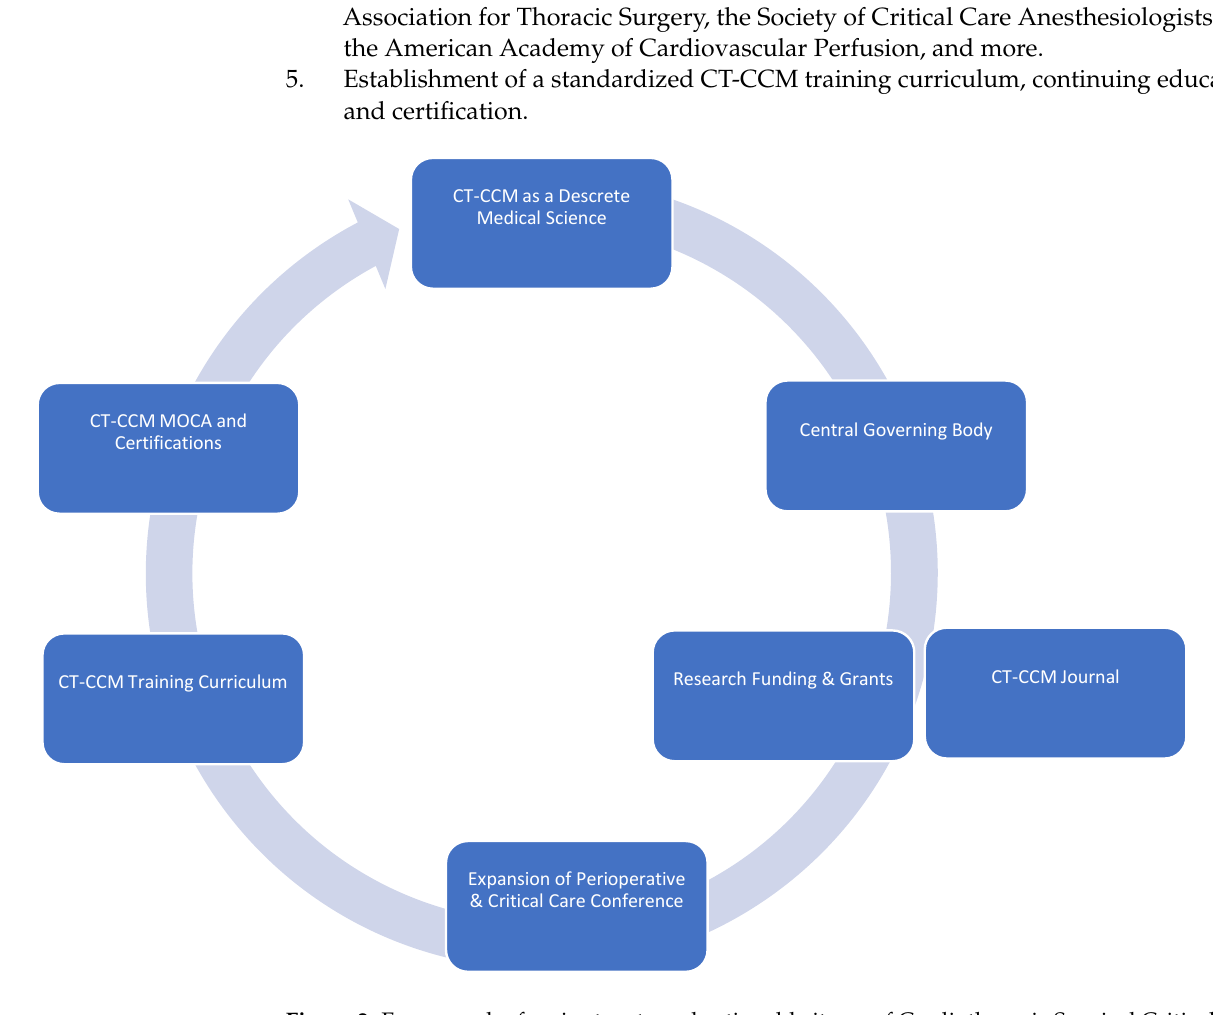
Figure 2. Framework of major tenets and actionable items of Cardiothoracic Surgical Critical Care Medicine.